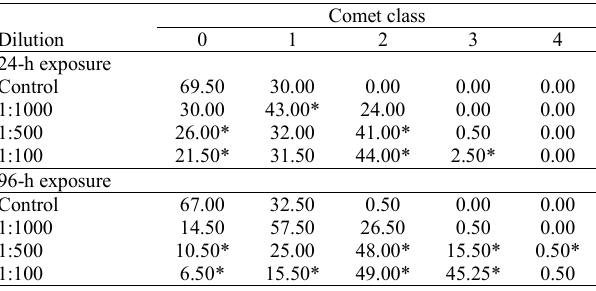
Table 1. DNA damage frequency (%) in erythrocytes of Prochilodus vimboides exposed to different water soluble fractions of diesel (1:1,000, 1:500 and 1:100) for 24 and 96 h. Median values are presented. *: Significant difference in one dilution in comparison to respective controls using a Kruskal- Wallis ANOVA and the Dunn’s test (p<0.05).